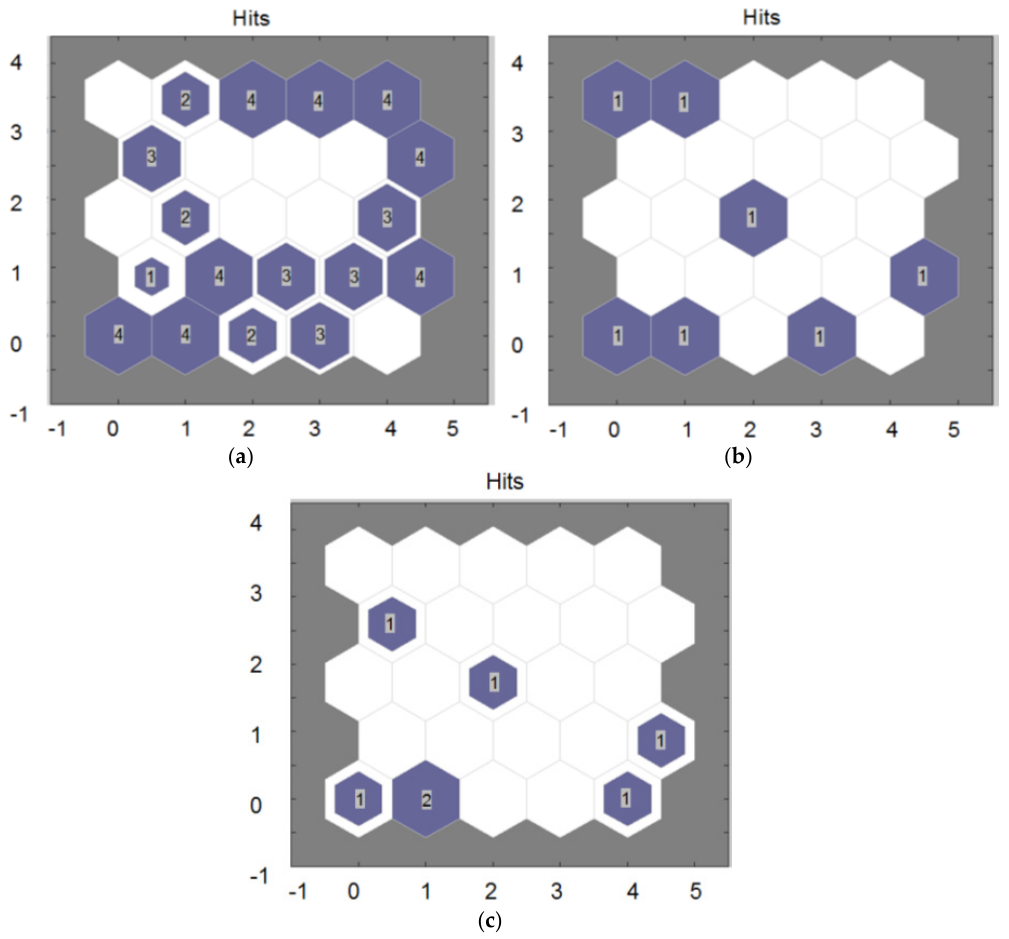
Figure 7. Structure for matching the input data in the processes of ( a ) training, ( b ) validation, and ( c ) testing.